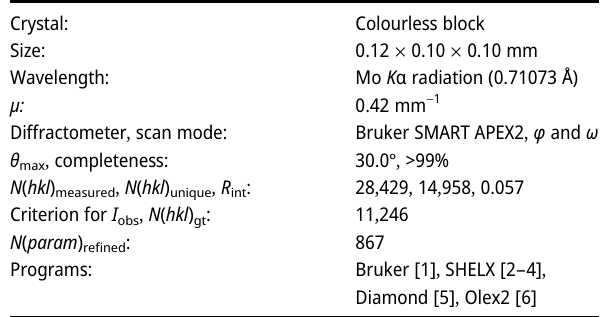
Table  : Data collection and